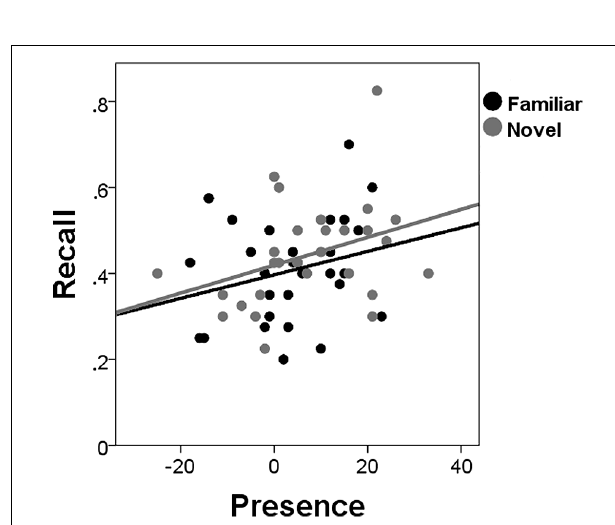
FIGURE 3 | Recall for low and high presence. The proportion of correctly remembered words after exploration of the novel and familiar environments relative to the respective IPQ scores